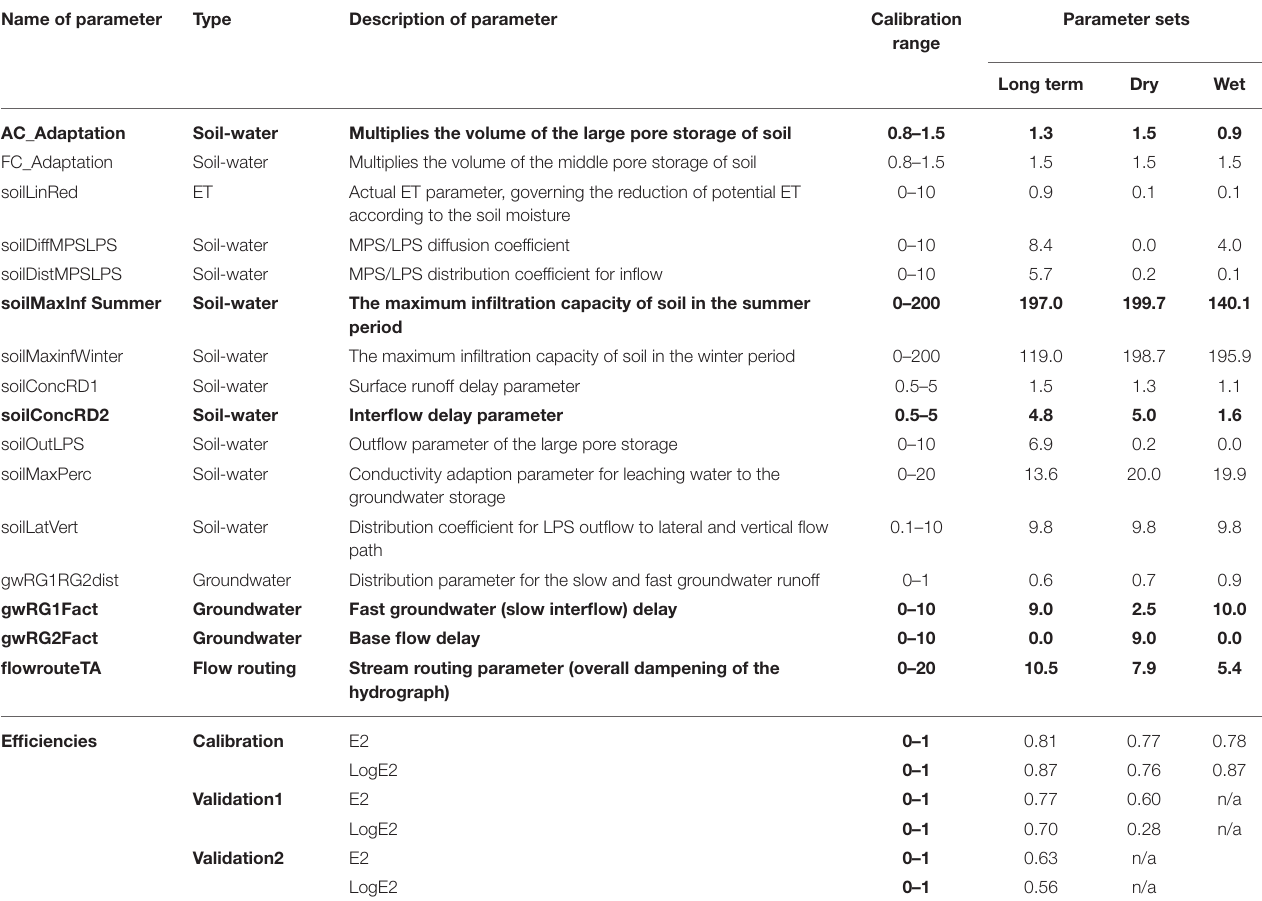
TABLE 3 | The selected parameters (from the NSGA-II) used for the JAMS/J2000 model to capture the hydrological behavior of the Berg River catchment, showing the Nash-Sutcliffe Efficiency (NSE; Nash, 1970) in standard form (E2), logarithmic form (logE2) results for the calibration (long-term 1984–1995, dry 1995, 1998,